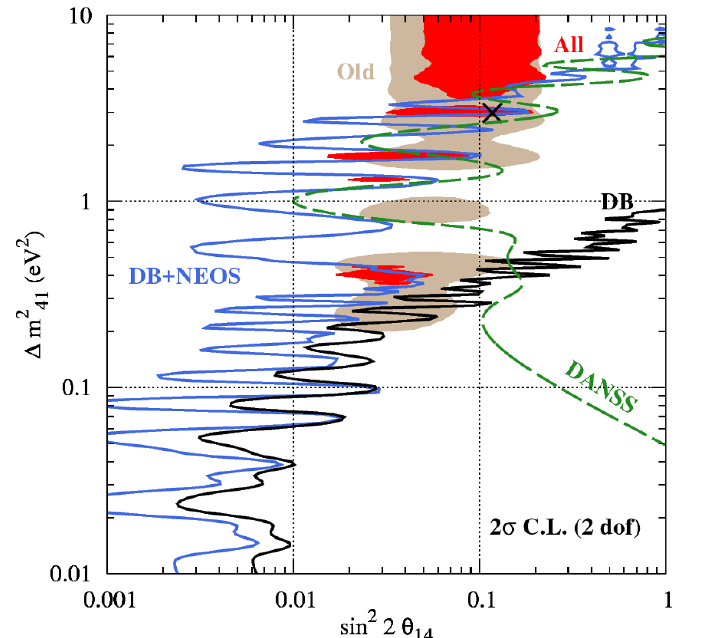
Figure 1 . Allowed parameter regions at 2 (cid:27) (2 dof) for the \(cid:13)ux-(cid:12)xed" analysis, for the \old" data sample de(cid:12)ned in table 2 (khaki regions), for the DANSS [28], Daya Bay spect. [46], the combined Day Bay spect. + NEOS [26] oscillation analyses, and the combined region of all data including also Daya Bay (cid:13)ux [29] (red regions). The cross marks the best (cid:12)t of the combined